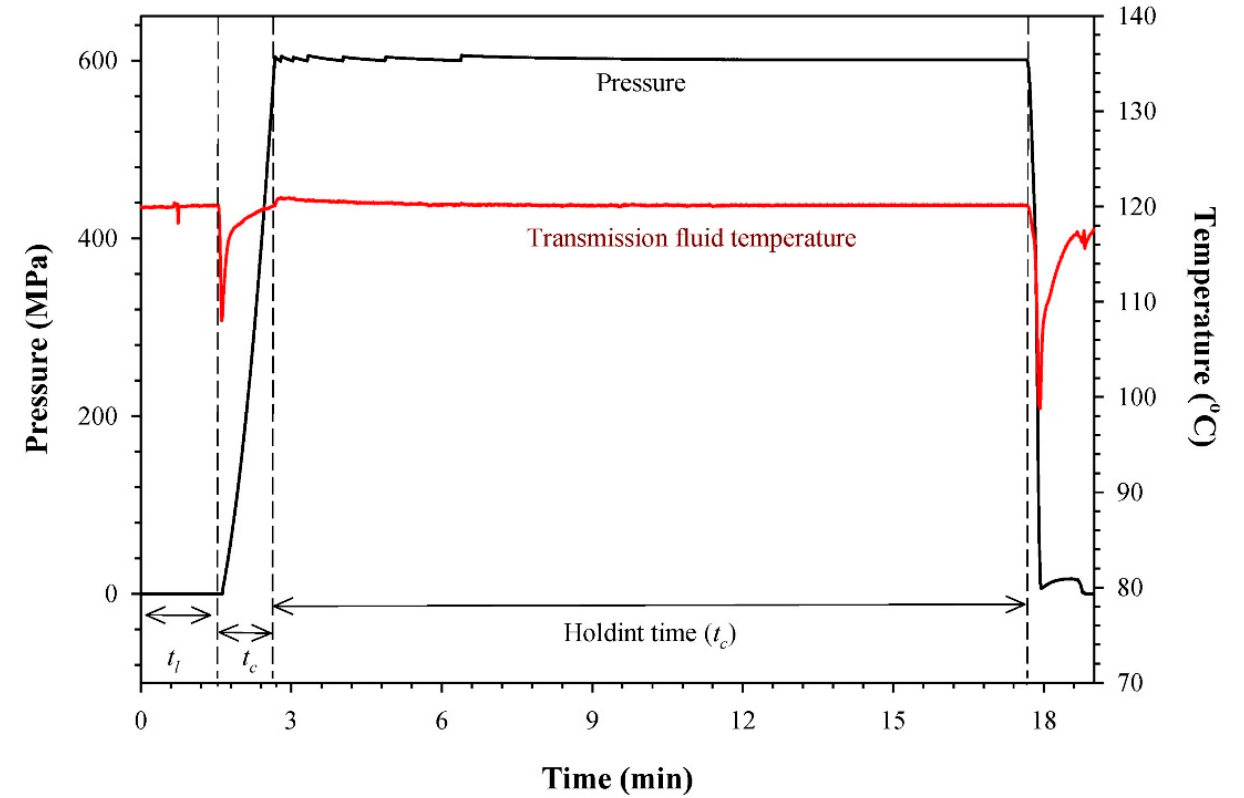
Figure 2. A graph indicating typical pressure, temperature and time history during pressure-assisted thermal processing of conjugated linoleic acid (CLA)-enriched milk treated at 600 MPa/120 °C (tl, loading time; tc, compression time; th, holding time [78] ) (reprinted from Combined Effect of Pressure-Assisted Thermal Processing and Antioxidants on the Retention of Conjugated Linoleic Acid in Milk. Martinez-Monteagudo, Sergio I., Saldaña, Marleny D.A.; Foods 2015; Vol. 4; Issue 2